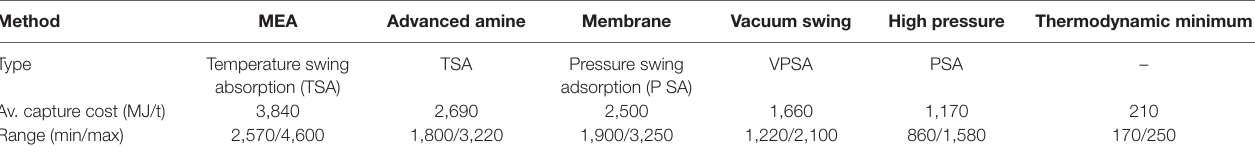
Table 1 | Comparison of average reported energy costs for several post-combustion CO 2 capture processes including maximum and minimum reported values (Desideri and Paolucci, 1999; Wong and Bioletti, 2002; Romeo et al., 2008; Zhang et al., 2008; Harkin et al., 2009; Rameshni, 2010; Yang and Zhai, 2010; Belaissaoui et al., 2012, 2013; Krishnamurthy et al., 2014; Kundu et al., 2014; Liu et al., 2014; Xie et al.,